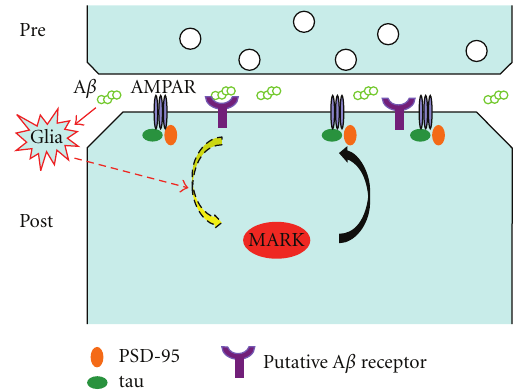
Figure 2: A diagram depicting a potential role of glia in mediating the synaptic toxicity of A β . A β oligomers presumably secreted from the presynaptic neuron could bind to its putative receptor on the postsynaptic cell, and this could then initiate a signaling cascade leading to activation kinases such as MARK, which then acts on tau, PSD-95, and possibly other synaptic substrates to a ff ect AMPAR removal from the synaptic surface, leading to synapse and spine loss. Alternatively, A β could act on glial cells near neuronal synapses, which then release factors such as cytokines to activate signaling molecules such as MARK and cause synapse and spine loss. These two mechanisms are not mutually exclusive and could in fact occur simultaneously to mediate A β